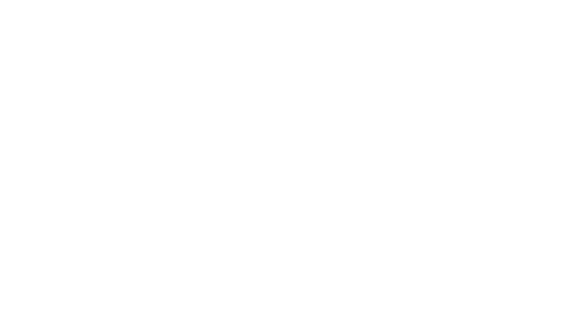
Table 2. Lubricating effect of shea lubricant and lidocaine gel. n, frequency.